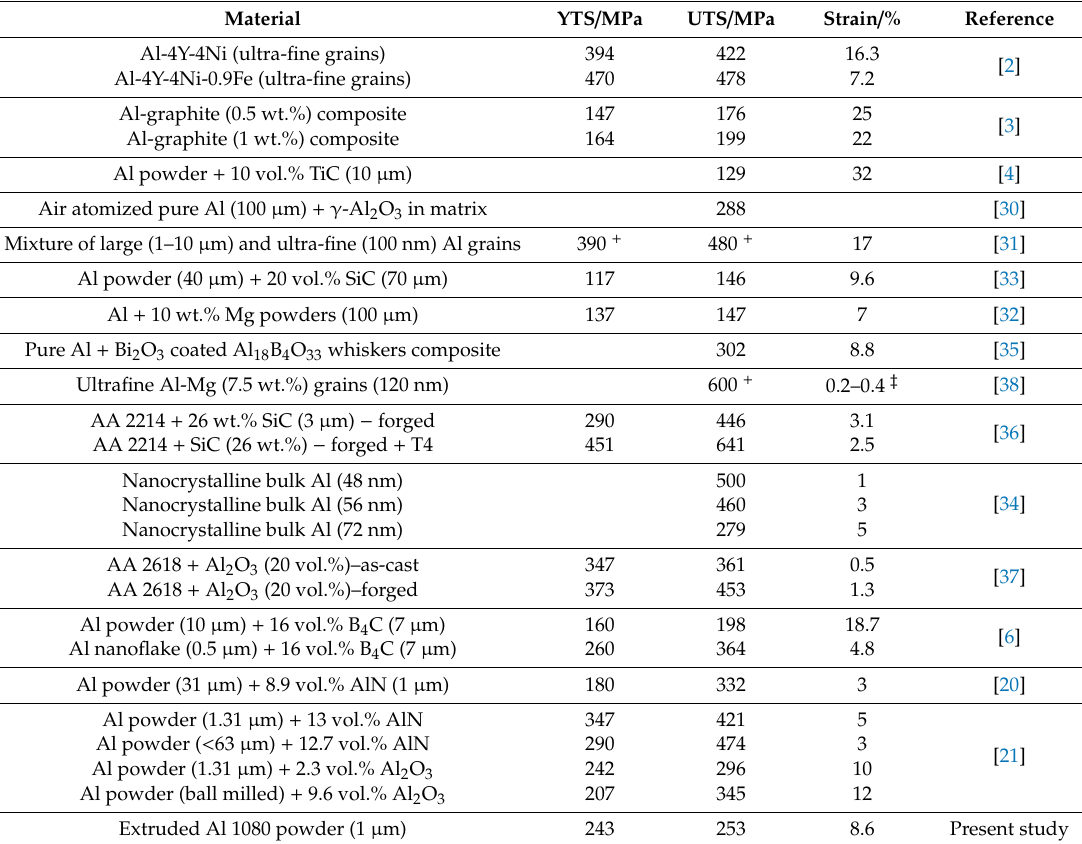
Table 5. Comparison of published room-temperature yield tensile strength, ultimate tensile strength and strains at fracture for various particle reinforced aluminum